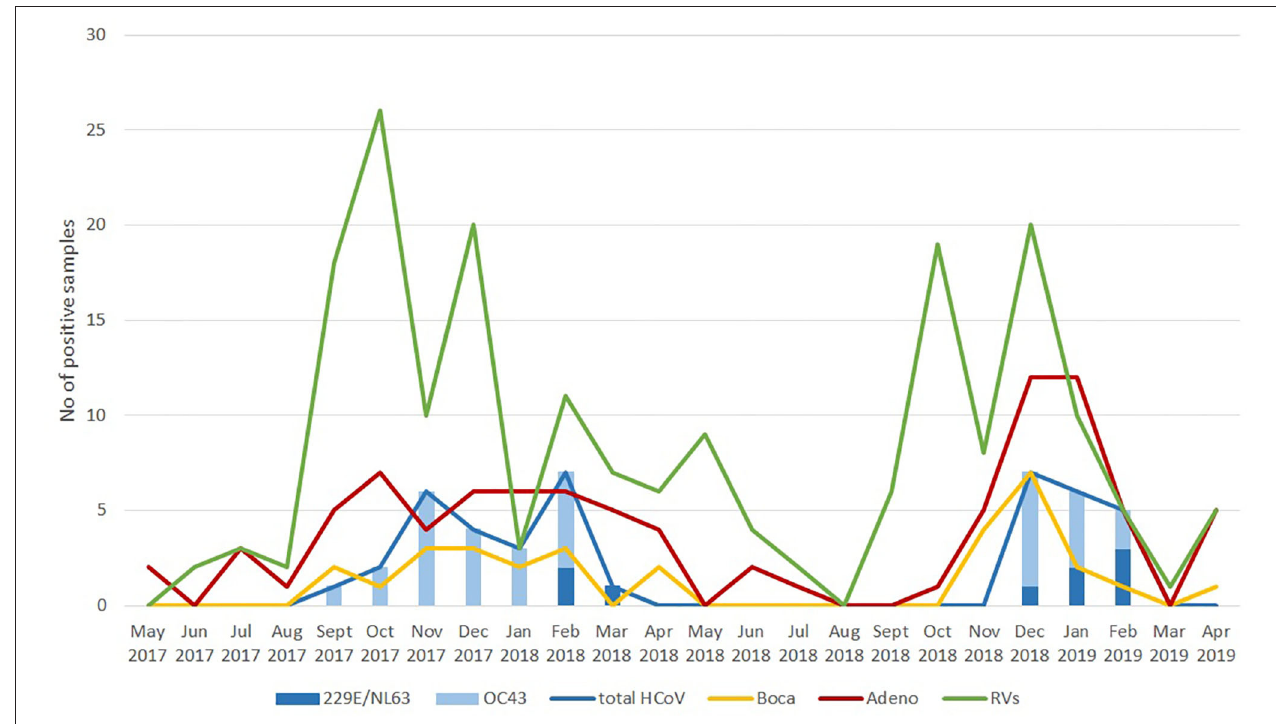
FIGURE 1 | Temporal distribution of cases positive for seasonal coronaviruses, rhinoviruses, adenoviruses, and bocaviruses in hospitalized Croatian children with acute respiratory infection from May 2017 to April